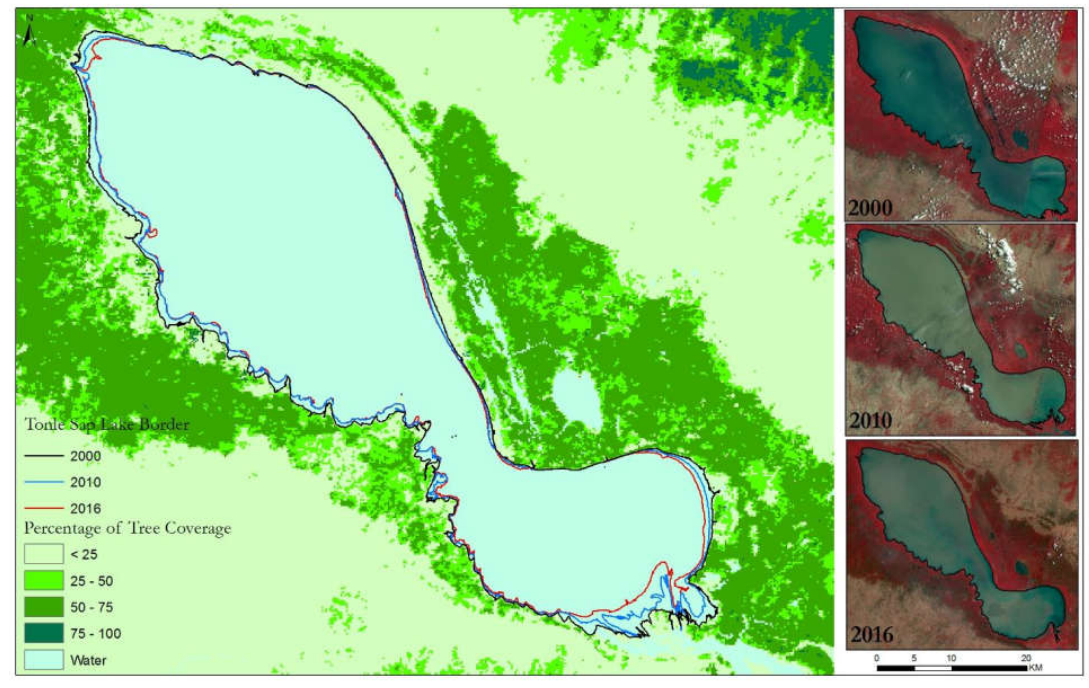
Figure 4. Changes in open water boundaries in the Tonle Sap Lake region extracted from Landsat imagery of 2000, 2010, and 2016 overlaid with Moderate Resolution Imaging Spectroradiometer (MODIS) vegetation continuous field (modified after Lin and Qi [67]).